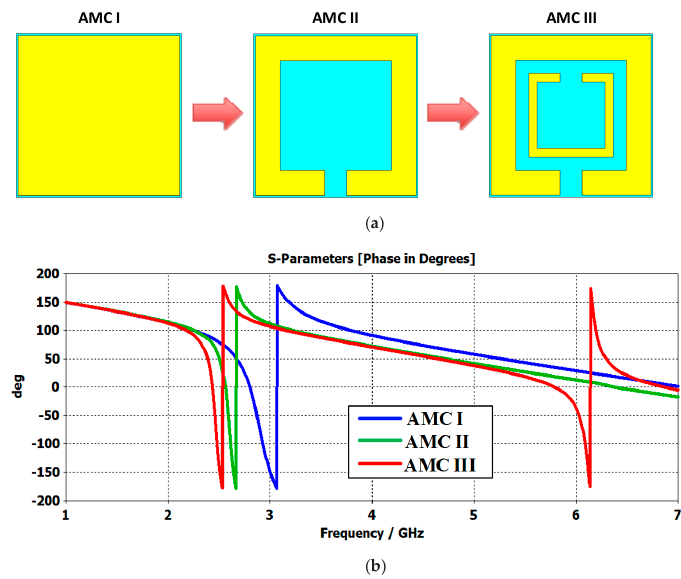
Figure 13. Unit cell ( a ) design steps; ( b ) unit cell phase.